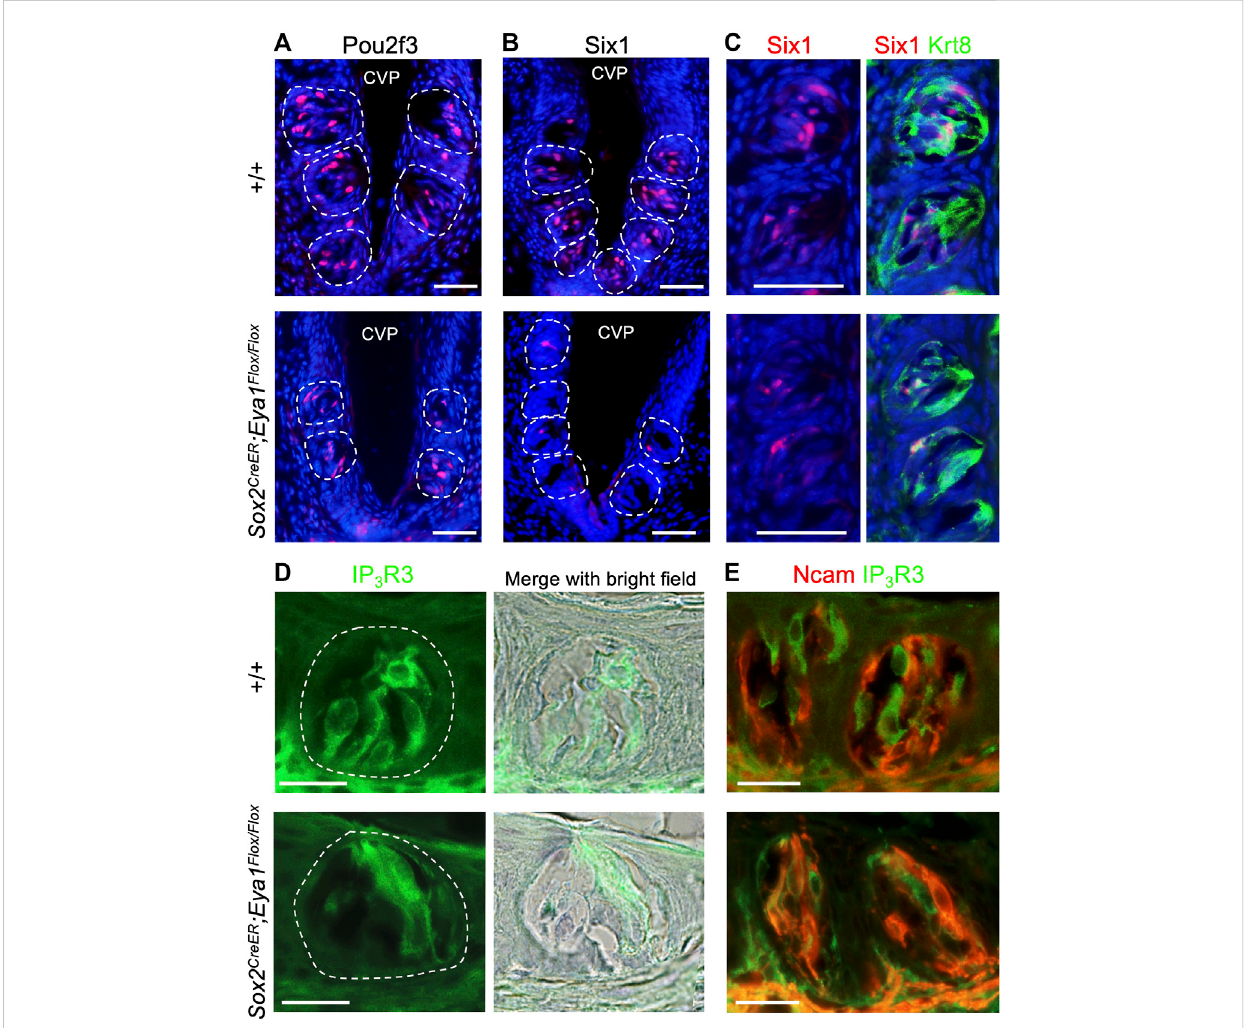
FIGURE 6 Conditional deletion of Eya1 leads to a reduction in the numbers of Pou2f3 + , Six1 + and IP 3 R3 + taste cells. (A – E) Immunostaining for Pou2f3 (A) , Six1 (B) , or co-immunostaining for Six1/Krt8 (C) , IP 3 R3 (D) or co-immunostaining for IP 3 R3/Ncam (E) in wild-type control and Eya1 cKO taste buds at ~6 – 8weeks ofage. Sectionswerealso counterstained with dilutedhematoxylin,andbright- fi eldimages weretaken tooutlinethetastebuds. Scalebars: 50 μ m (A – C) and 20 μ m (D, E) .